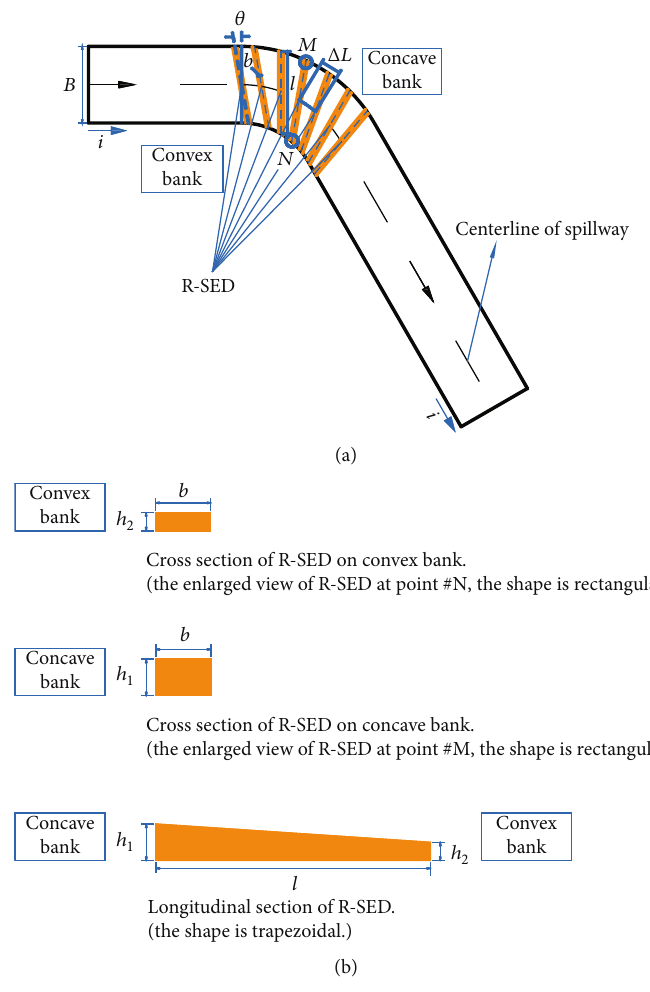
Figure 2: (a) Schematic diagram of R-SEDs arrangement in the curved spillway and related parameters; (b) schematic diagram of R-SED structure.